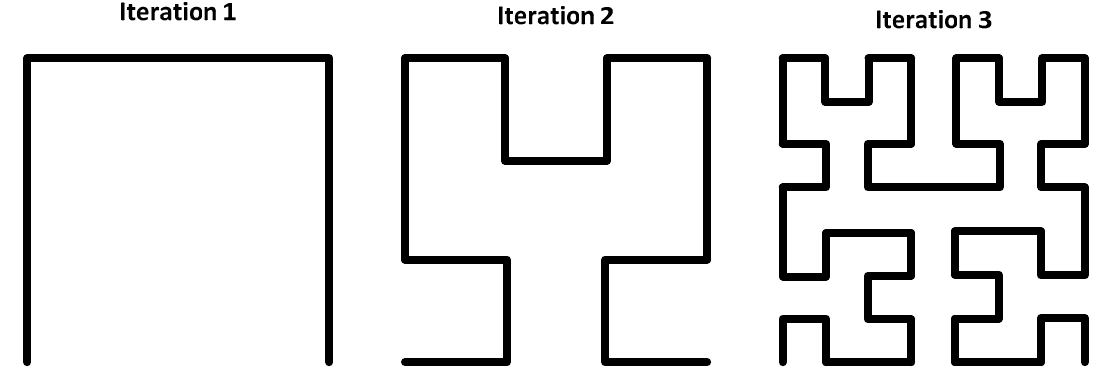
Figure 8. Hilbert Space Filling Curve Geometries (1–3)—Adapted from Reference [123].